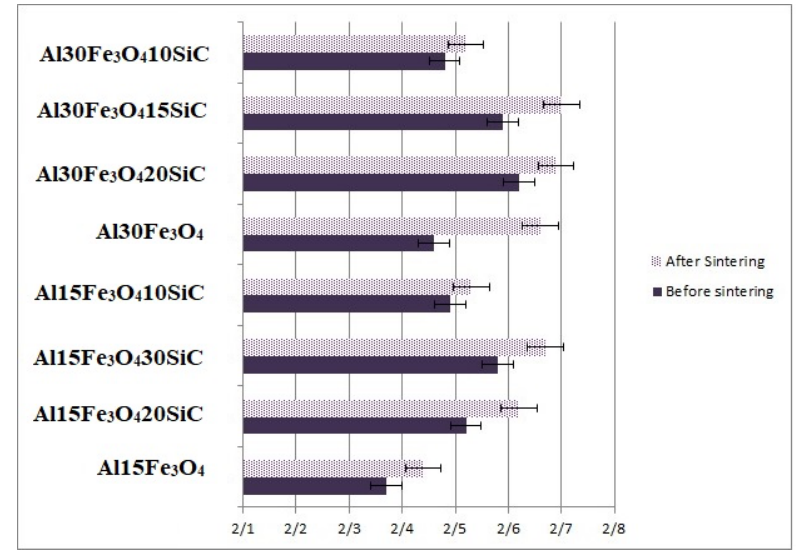
Figure 7. Evolution of density, both after and before sintering, depending on hybrid filler.